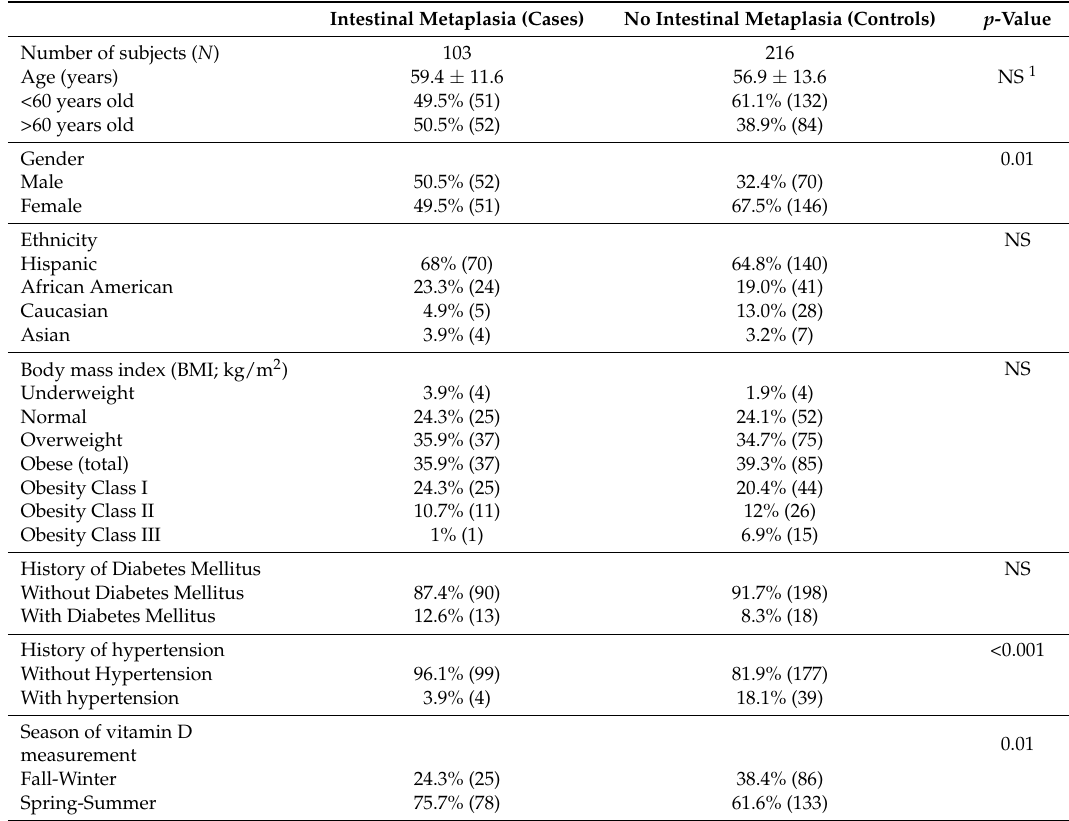
Table 1. Demographic information of case and control